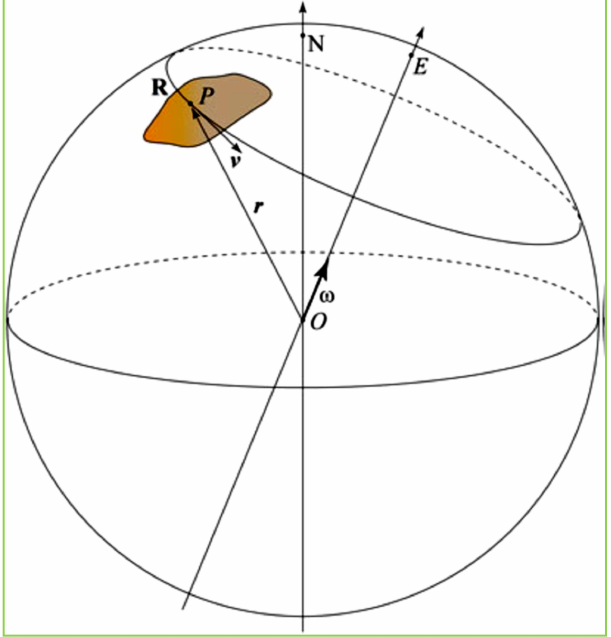
Figure 8. Geometry of the instantaneous motion of a tectonic plate R . E is the Euler pole, N is the North Pole. P is a representative point on R , whose instantaneous linear velocity is v . ω is the Euler vector of R ; from